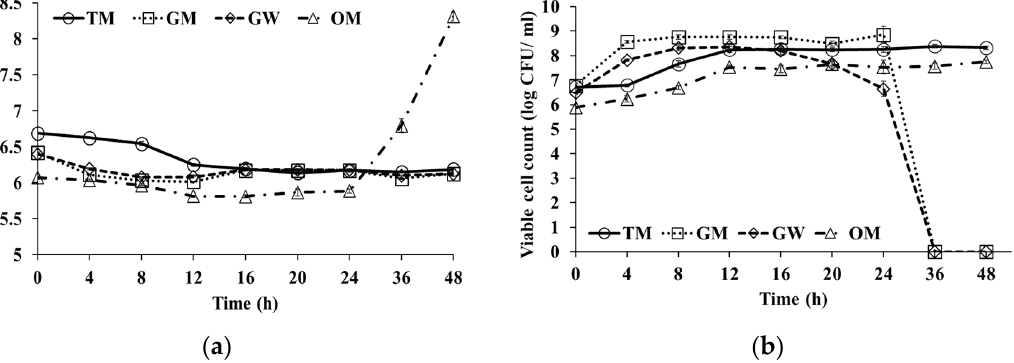
Figure 1. Changes in pH ( a ) and viable cell count ( b ) before and after fermentation of 5% ( w/v ) tur ‐ meric, ganghwa mugwort, glasswort, and omija. TM: turmeric; GM: ganghwa mugwort; GW: glasswort; OM, omija.